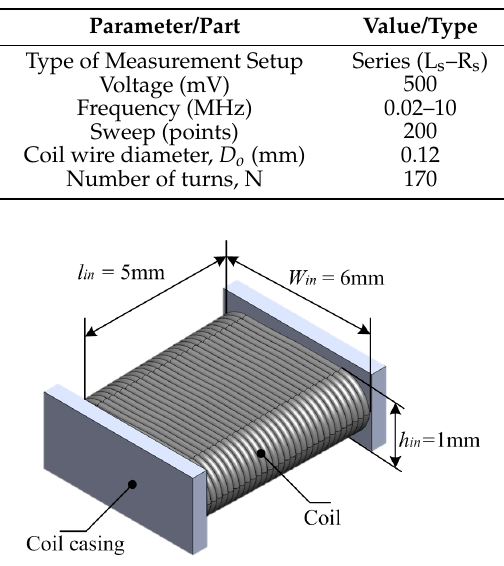
Figure 3. Flat-type air coil 3D structure.